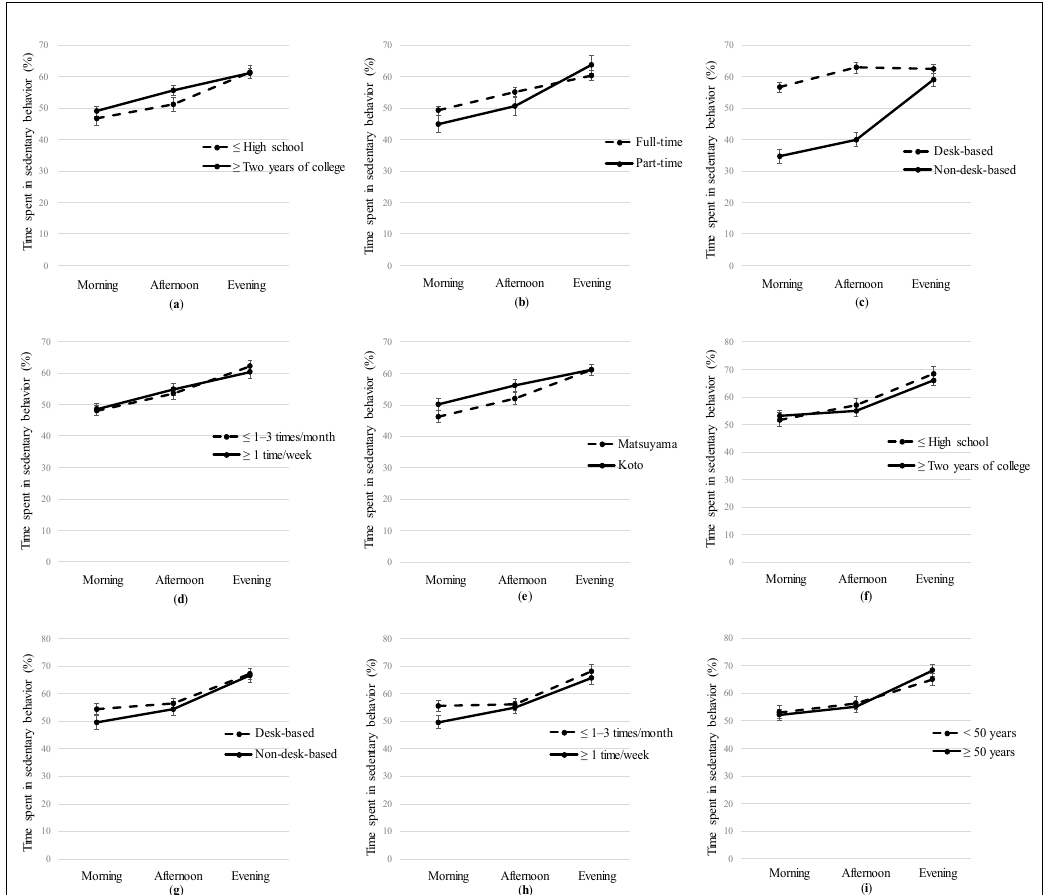
Figure 2. Diurnal patterns of sedentary behavior by sociodemographic group. SB—sedentary behavior. The interaction effects of the proportion of sedentary time between subgroups of each sociodemographic variable were examined using multilevel mixed-effects linear regression, and stratified analysis was conducted for variables that showed significant interactions: ( a ) Workday SB by education attainment; ( b ) Workday SB by employment status; ( c ) Workday SB by workstyle; ( d ) Workday SB by alcohol consumption; ( e ) Workday SB by residential area; ( f ) Nonworkday SB by educational attainment; ( g ) Nonworkday SB by workstyle; ( h ) Nonworkday SB by alcohol consumption; ( i ) Nonworkday SB by age. The values were expressed as means and 95% confidence intervals.